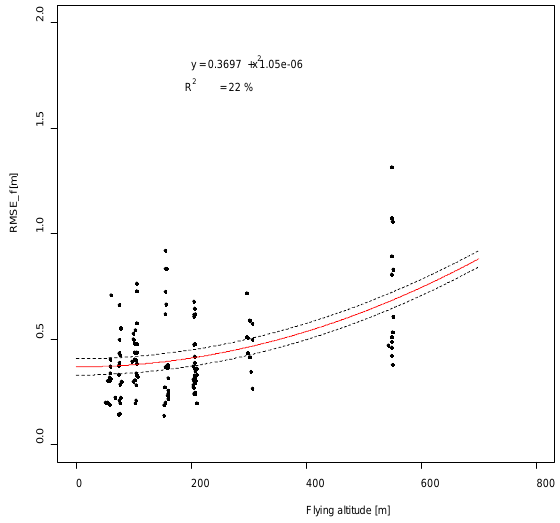
Figure 10. RMSE (determined with LiDAR reference) in relation to the flight altitude.